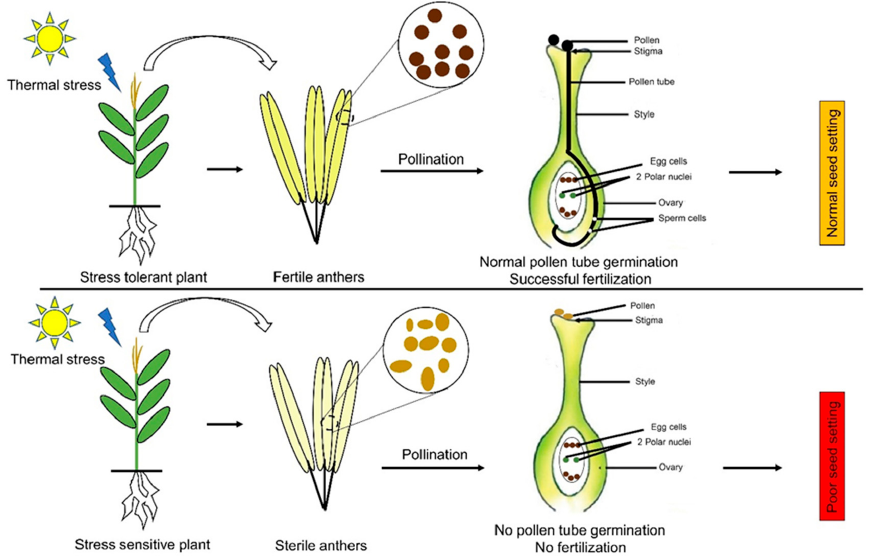
Figure 3. The influence of thermal stress on reproductive development in maize. Thermal stresses cause anther sterility and pollen abortion in the sensitive varieties, which lead to a lack of pollen tube growth and fertilization. This abnormality ultimately leads to a lack of seed setting in the maize cobs. On the other hand, tolerant varieties maintain their anthers and thus have viable pollens inside them, which leads to successful fertilization and normal seed setting.